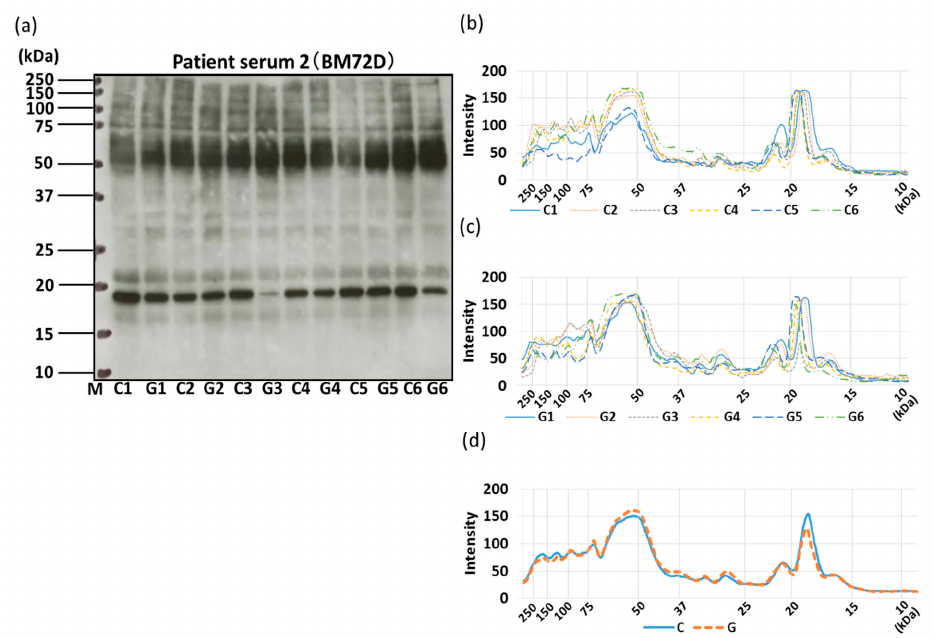
Figure 12 . IgE-immunoblotting of GM-and non-GM soybeans using patient serum 2. A representative IgE-immunoblot of GM soybeans (G1–G6) and non-GM soybeans (C1–C6) is shown (a) . Immunoblots were analyzed on each soybean sample once by densitometry and separated into non-GM soybean (b) and GM soybean groups (c) . The average IgE-immunoblot profiles of non-GM soybeans and GM soybeans were calculated (d) .